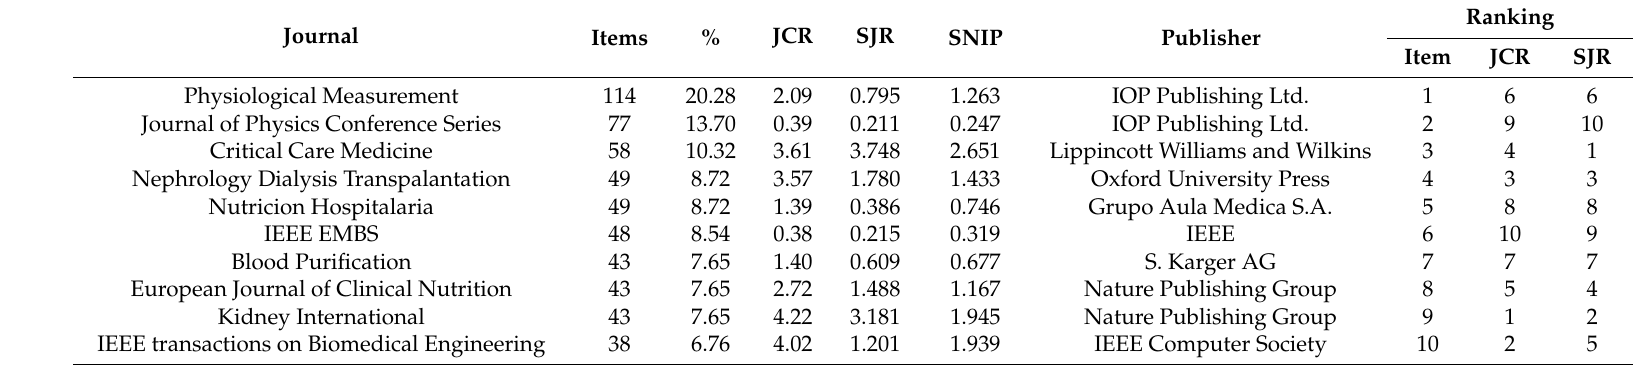
Table 2. Top 10 ranking journals in